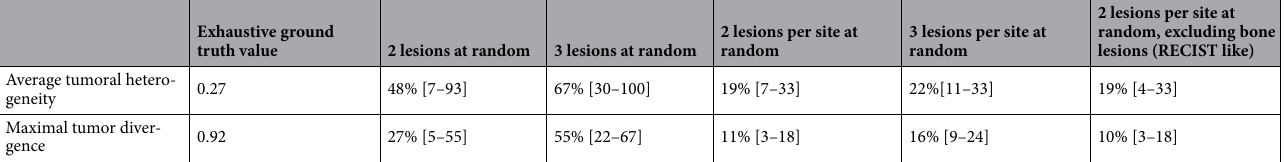
Table 2. Percentage of heterogeneity recovered by each tumor sampling strategy (mean values and their 95% confidence interval obtained using 500 simulations for each).